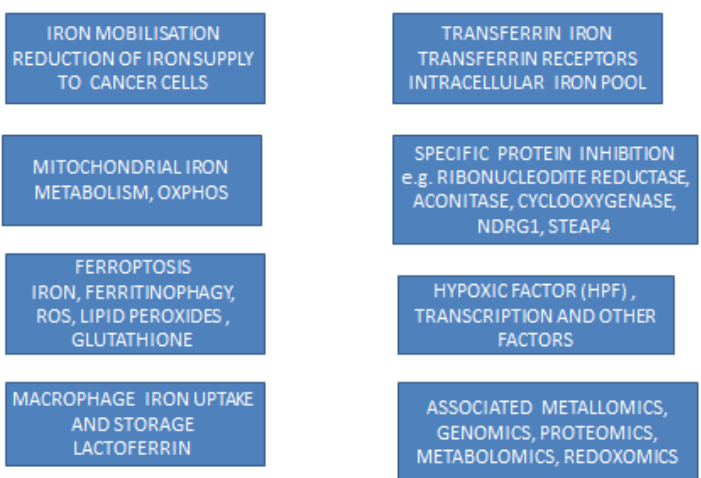
Figure 5. Modulation and targeting by iron chelators of iron metabolic pathways and activities of biomolecules, organelles and cells related to cancer formation, proliferation, metastasis and drug resistance affecting almost all types of cancer. NDRG1: N-MYC downstream-regulated gene-1; OXPHOS: oxidative phosphorylation; ROS: reactive oxygen species; STEAP4: six-transmembrane epithelial antigen of prostate, family member 4.